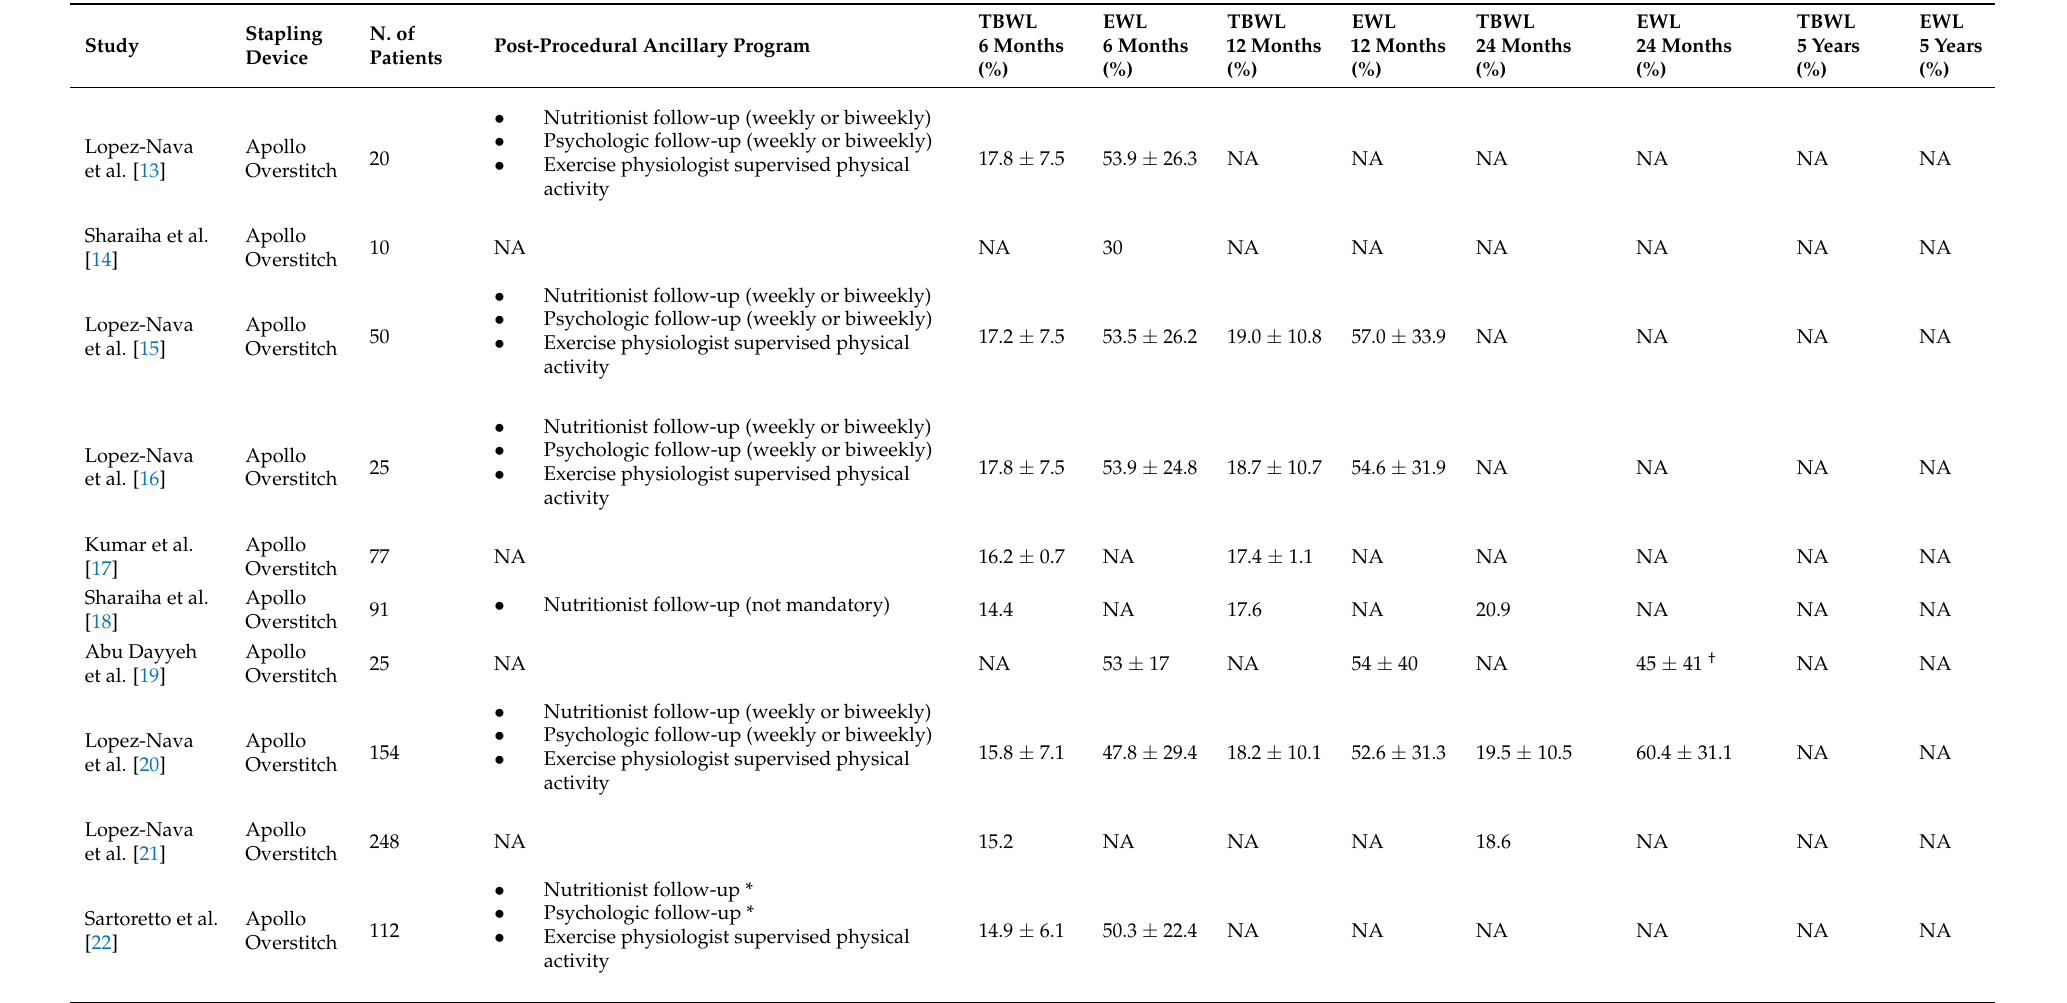
Table 2. Summary of weight loss outcomes and post-procedural ancillary programs of each